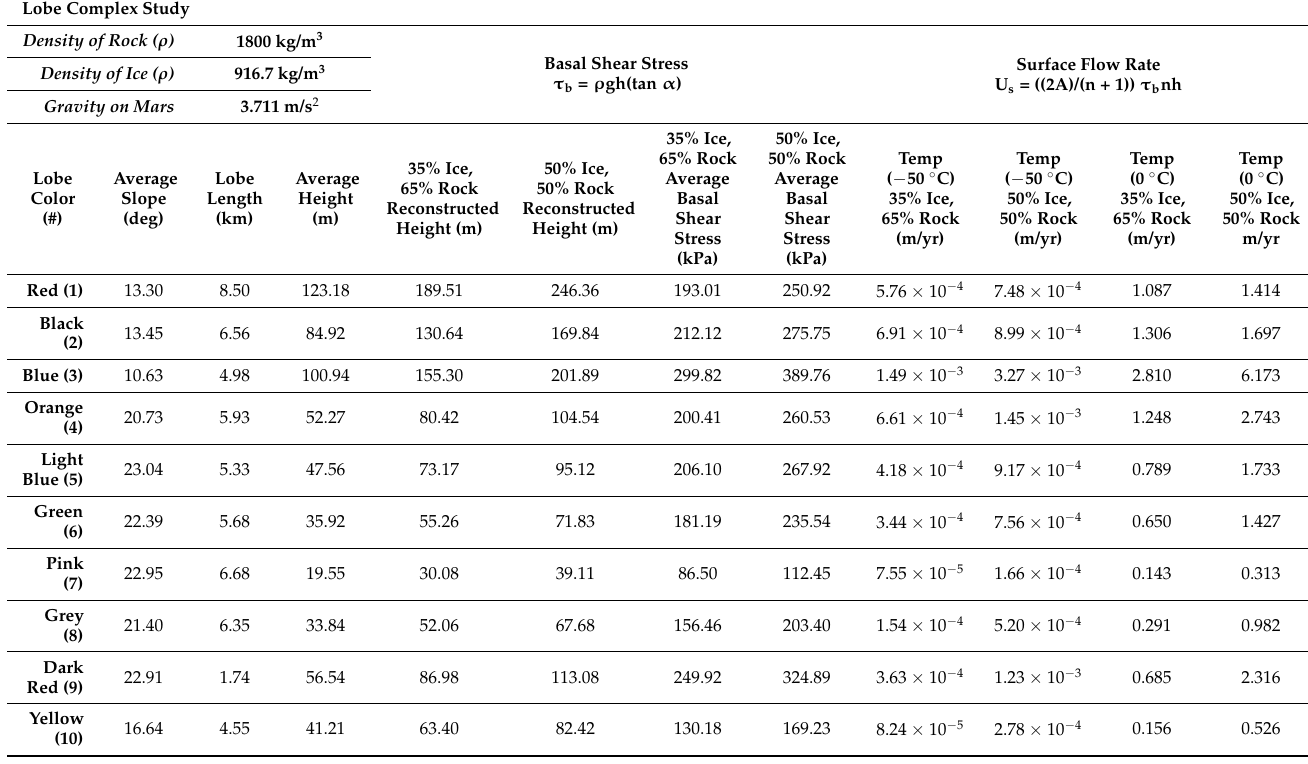
Table 3. Basal Shear Stress and Surface Flow data averages for all 10 lobate forms shown in Figure